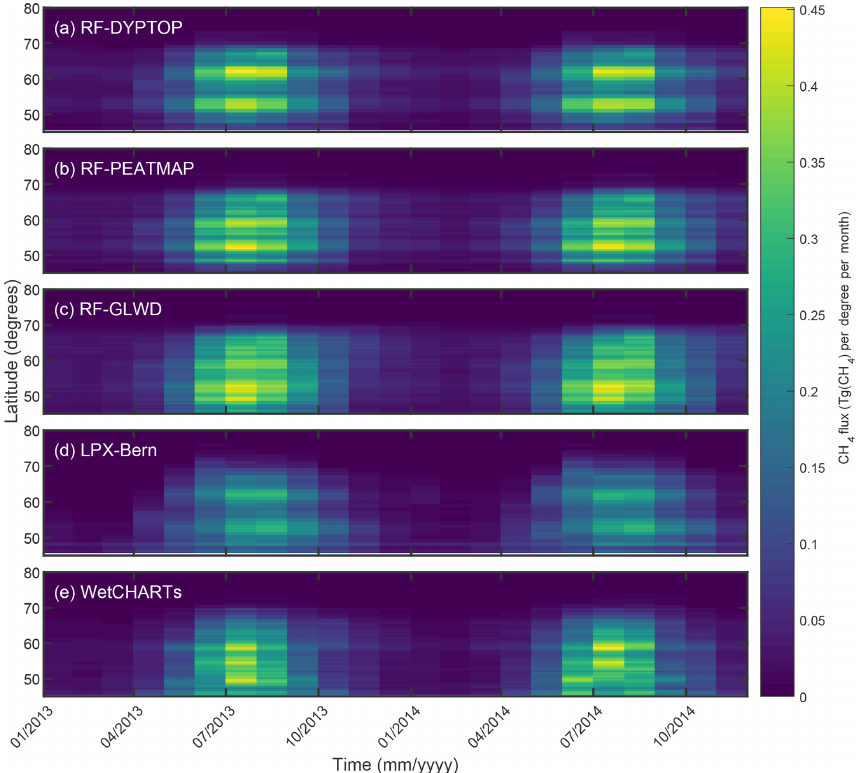
Figure 10. Monthly time series of zonal mean CH 4 fluxes. The upscaled fluxes with different wetland maps are shown in (a, b, c) and wetland CH 4 emissions estimated with the two process models are given in (d, e) .